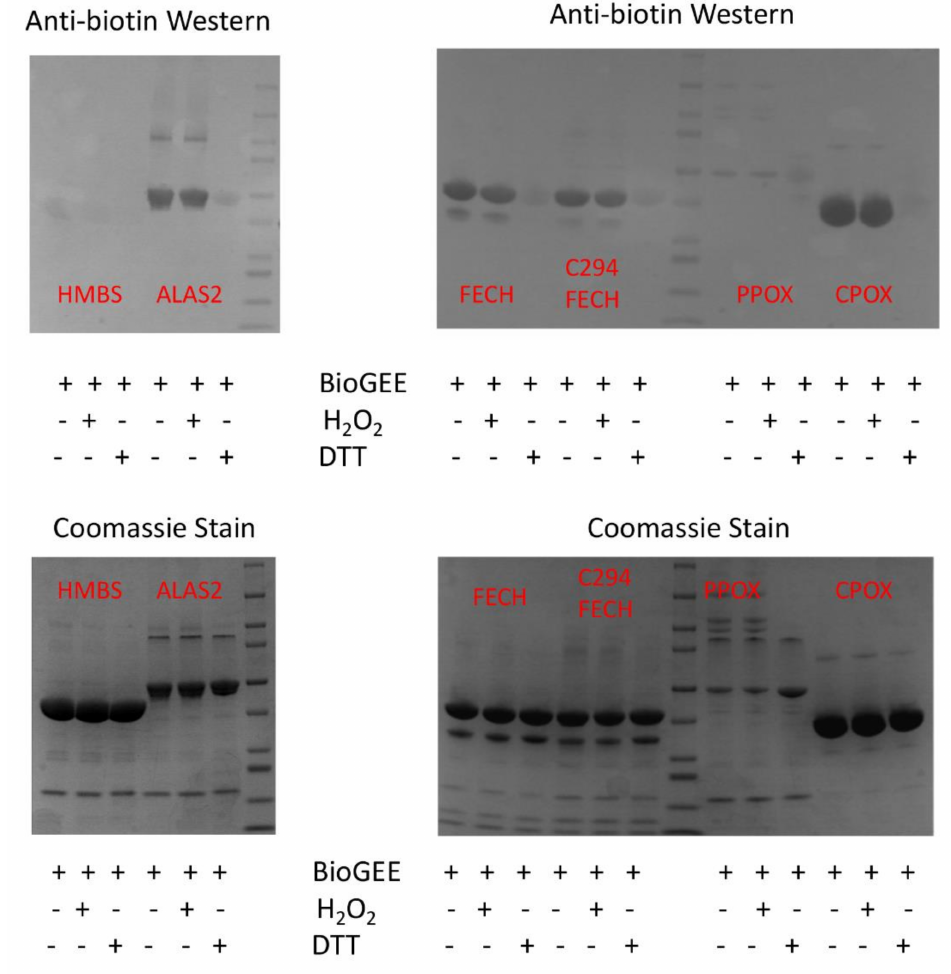
Figure 8. Some recombinant human heme biosynthetic enzymes are glutathionylated by BioGEE. Medlock and Dailey personal communication. Purified recombinant human heme biosynthetic enzymes [81,84,98,99], approximately 100 µ M, were incubated with 500 µ M BioGEE. In some samples, 1 µ M H 2 O 2 was added to facilitate glutathionylation via a sulfenic acid intermediate, and in some 10 mM DTT was added to demonstrate thiol specificity. Samples were separated by SDS-PAGE and subjected to Western blots using anti-biotin (Sigma) (top) and Coomassie staining (bottom). A representative of the two experiments is